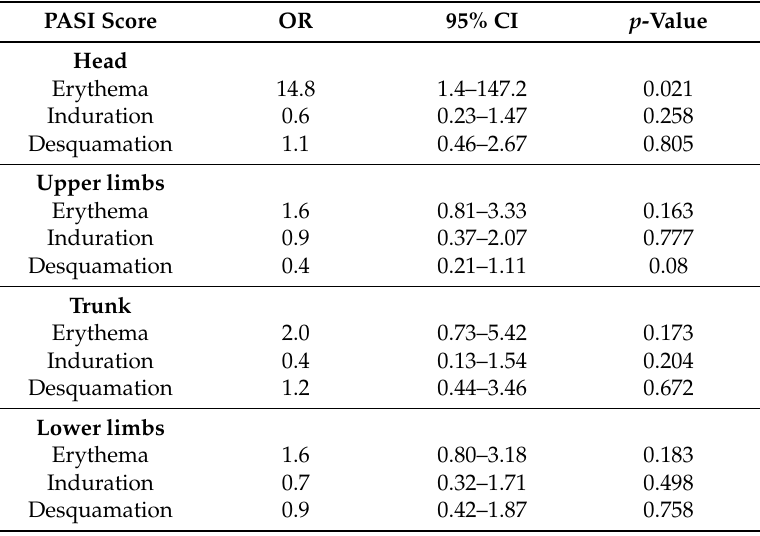
Table 3. PSQI and PASI